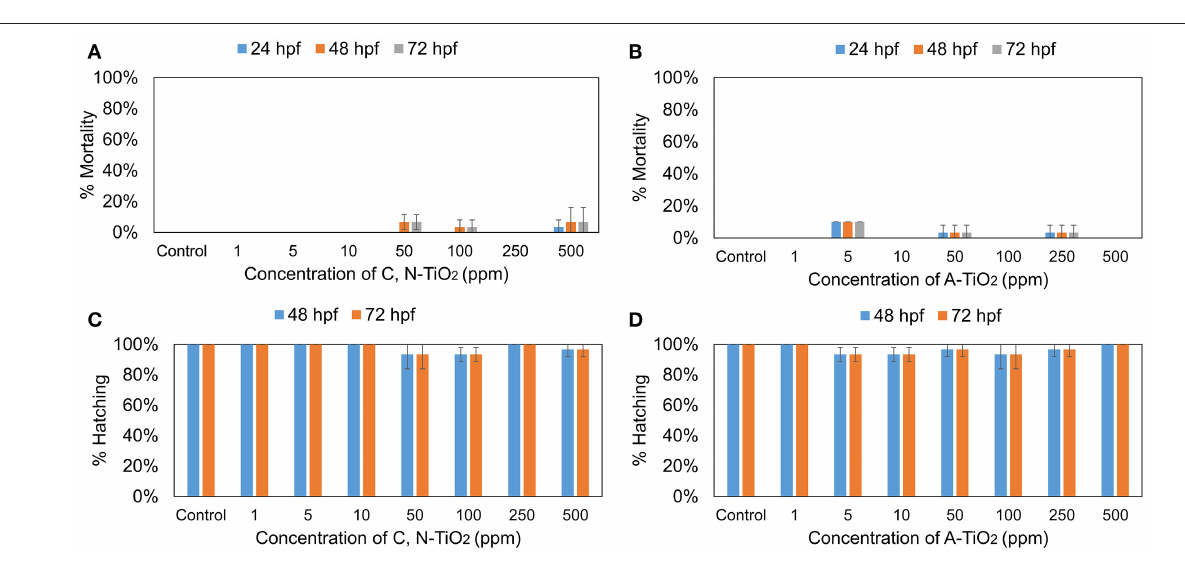
FIGURE 6 | (A,B) Mortality rate and (C,D) Hatching rate of zebrafish treated with C, N-TiO 2 and A-TiO 2 . (Values are expressed as means ± S.D).